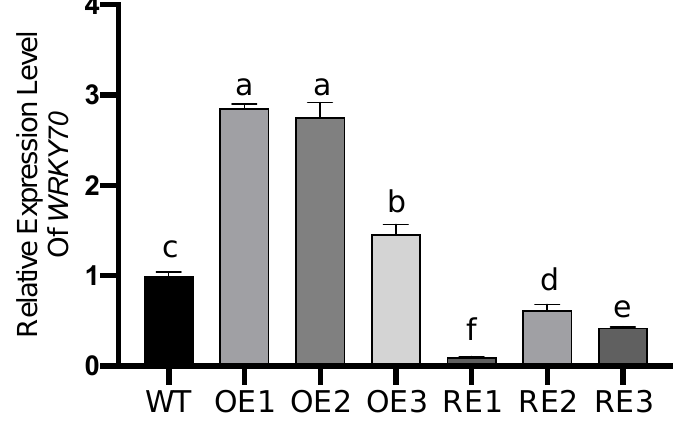
Figure 2. The expression levels of PsnWRKY70 in leaves of transgenic and WT lines in poplar. The means and standard errors were calculated with six replications. Multiple comparison was used via Duncan test. Different letters indicate significant differences ( p < 0.05).